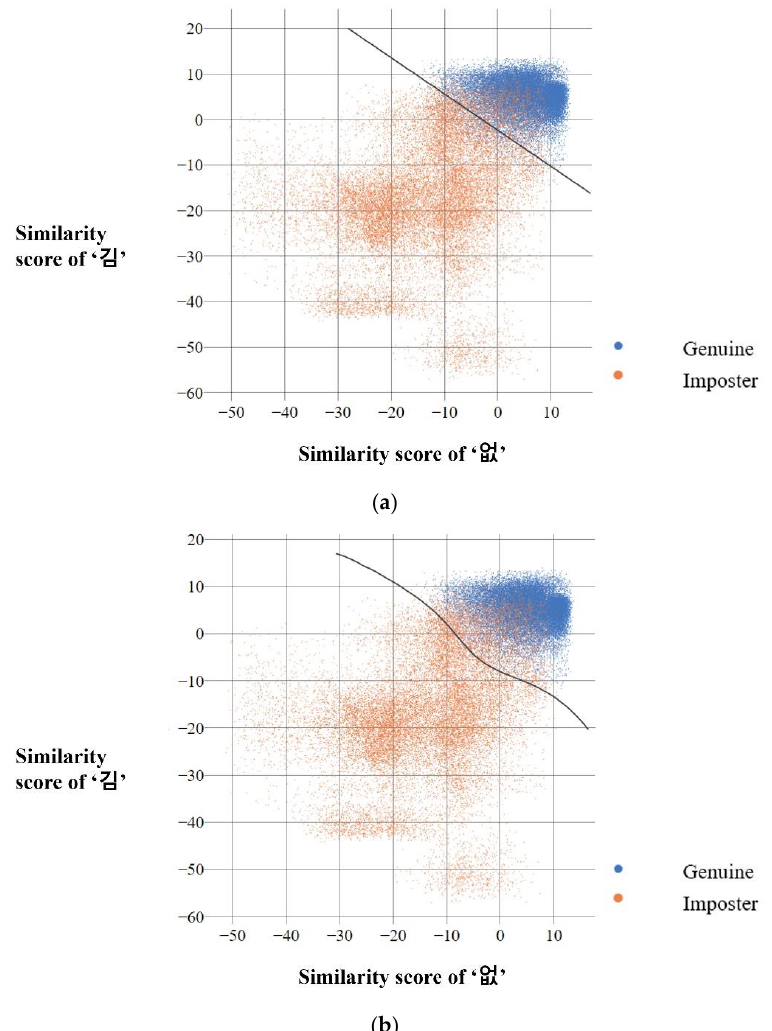
Figure 7. Scatter plots of multimodal of two characters with a classifier: ( a ) linear kernel boundary; ( b ) RBF kernel boundary.